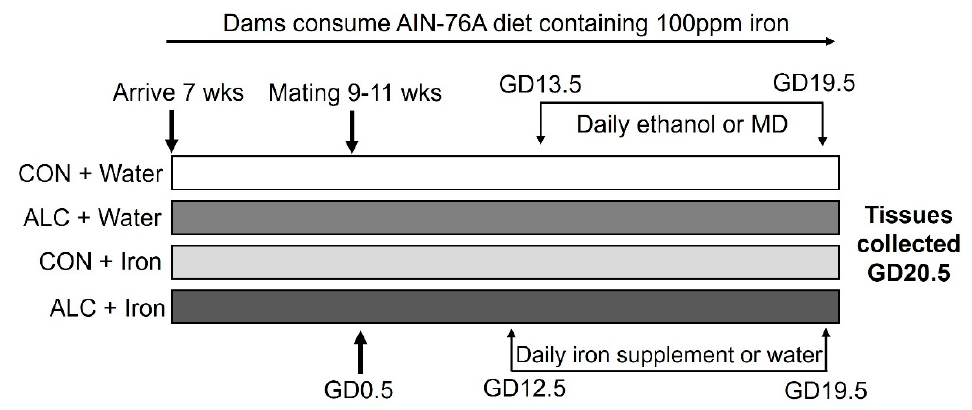
Figure 1. Study design. ALC, alcohol exposed; CON, control; GD, gestational day; MD, maltodextrin; wks, weeks.